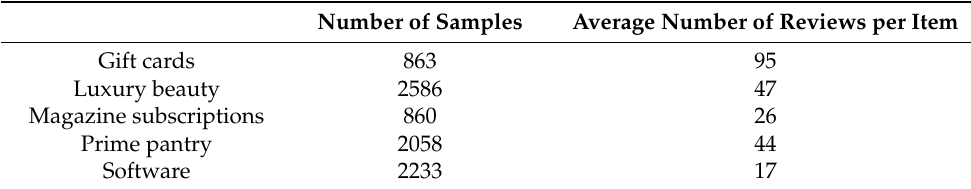
Table 2. Basic parameters of the Amazon dataset.